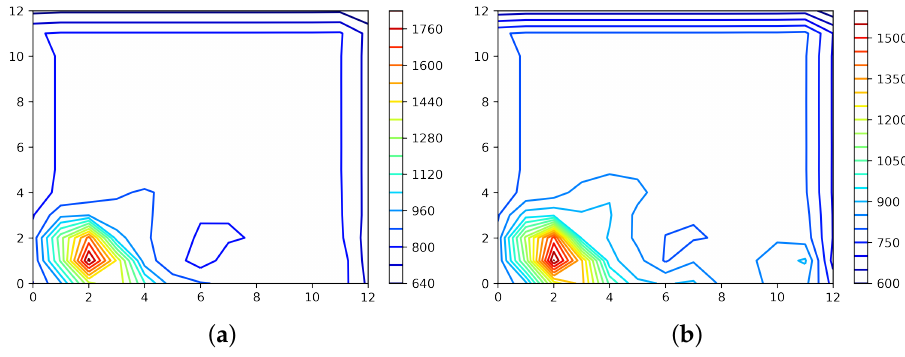
Figure 12. Drinking water feature spectrum of ( a ) training set and ( b ) test set using